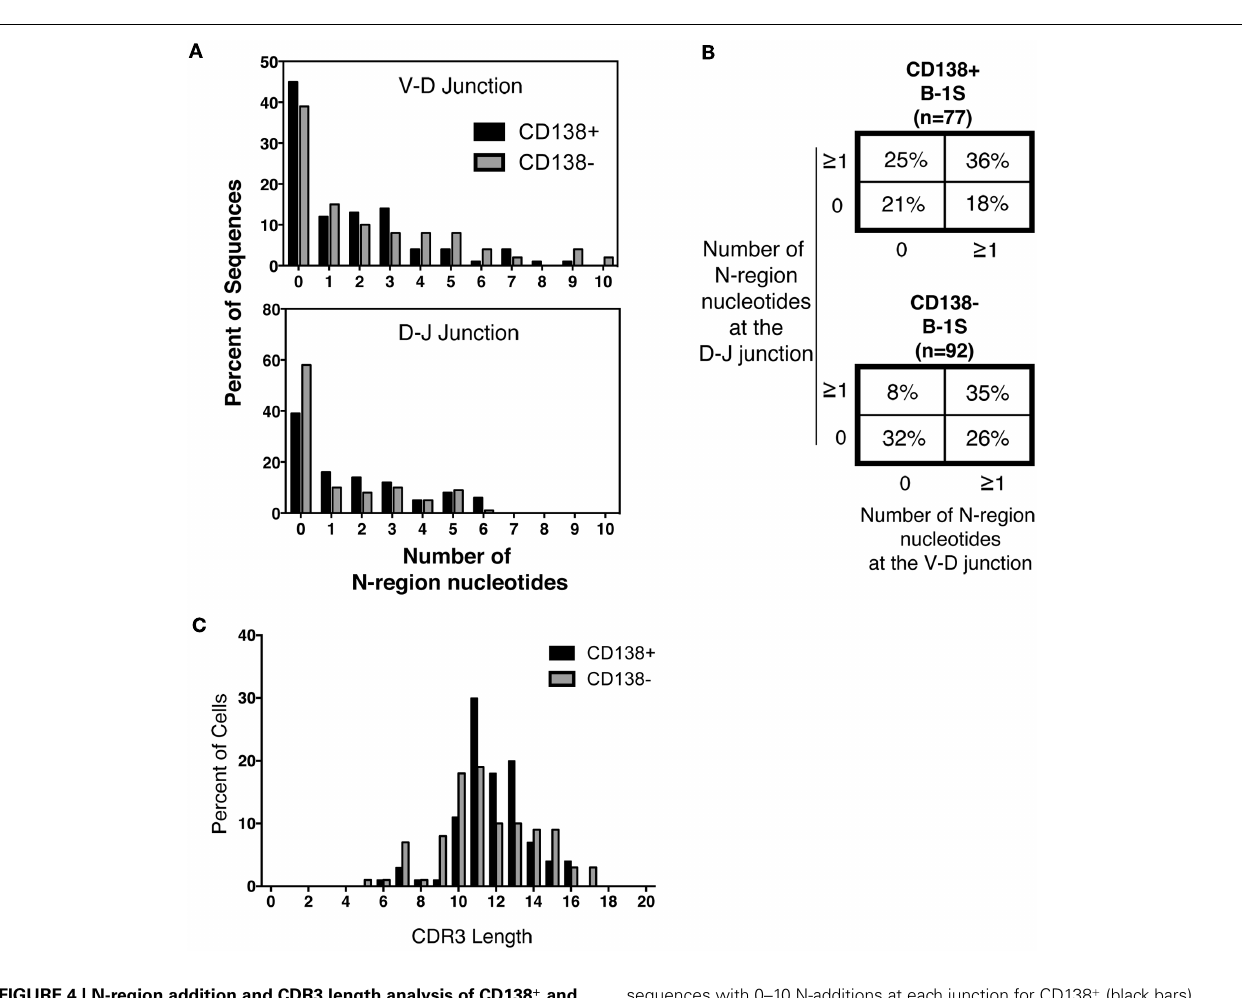
FIGURE 4 | N-region addition and CDR3 length analysis of CD138 + and CD138 − splenic B-1a cells. Immunoglobulins were amplified by PCR from single sorted splenic CD138 + ( n = 77) and CD138 − ( n = 92) B-1a cells and evaluated for N-region additions and CDR3 lengths. (A) The number of N-additions at each junction is shown.The graphs display the percent of